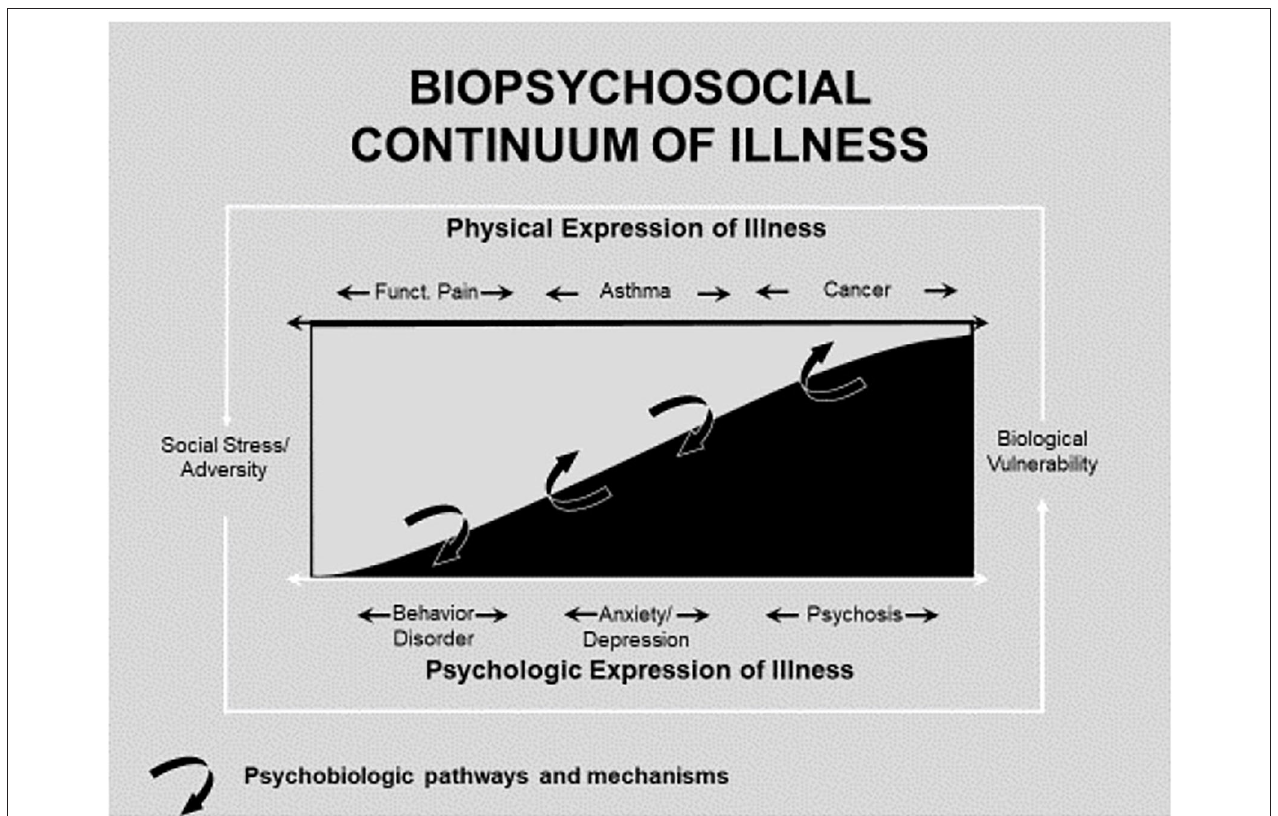
FIGURE 1 | Biopsychosocial continuum of illness [reformulated from Miller and Wood